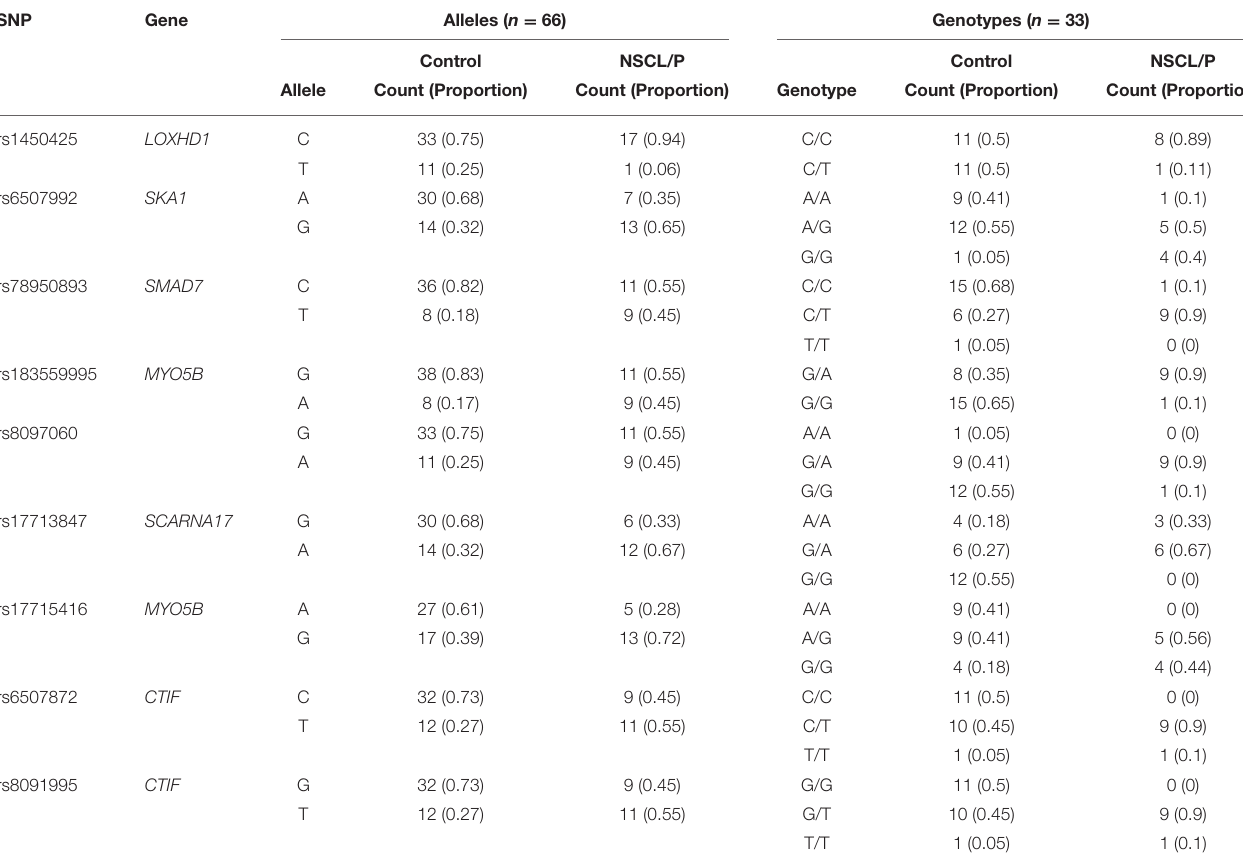
TABLE 4 | Details of allele and genotype frequencies of the significant SNPs genotyped in NSCL/P family members obtained using snpStats. SNP